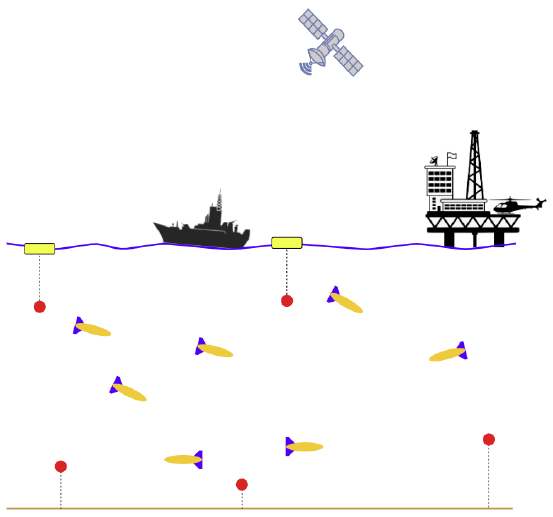
Figure 1. Underwater wireless network of Autonomous Underwater Vehicles (yellow vessels with blue fins) and anchored sensors